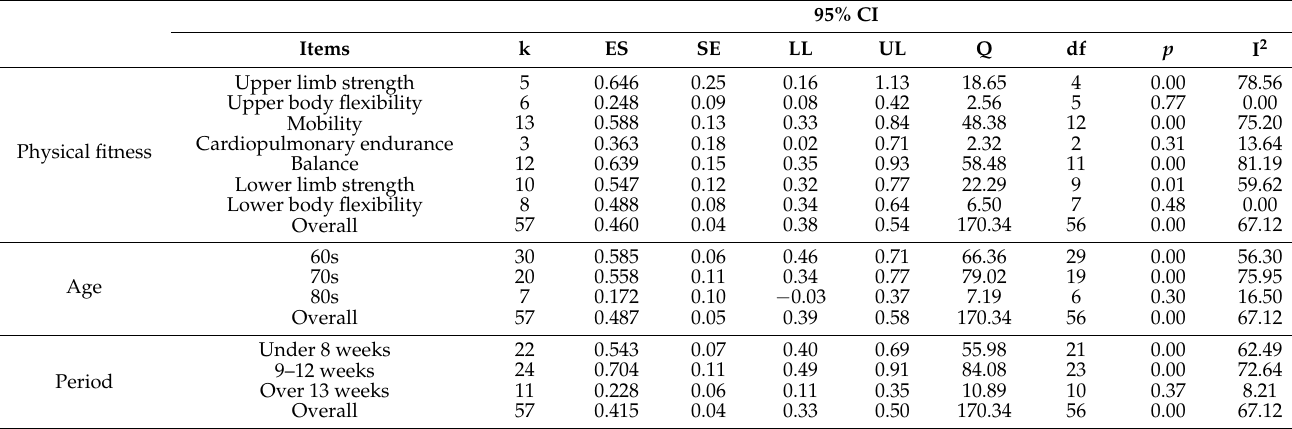
Table 3. Sub-group analysis results—effect sizes and